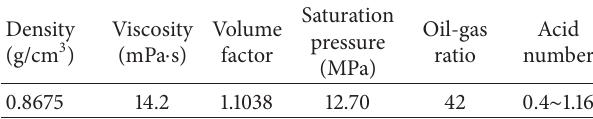
Table 4: Characteristics of crude oil under reservoir